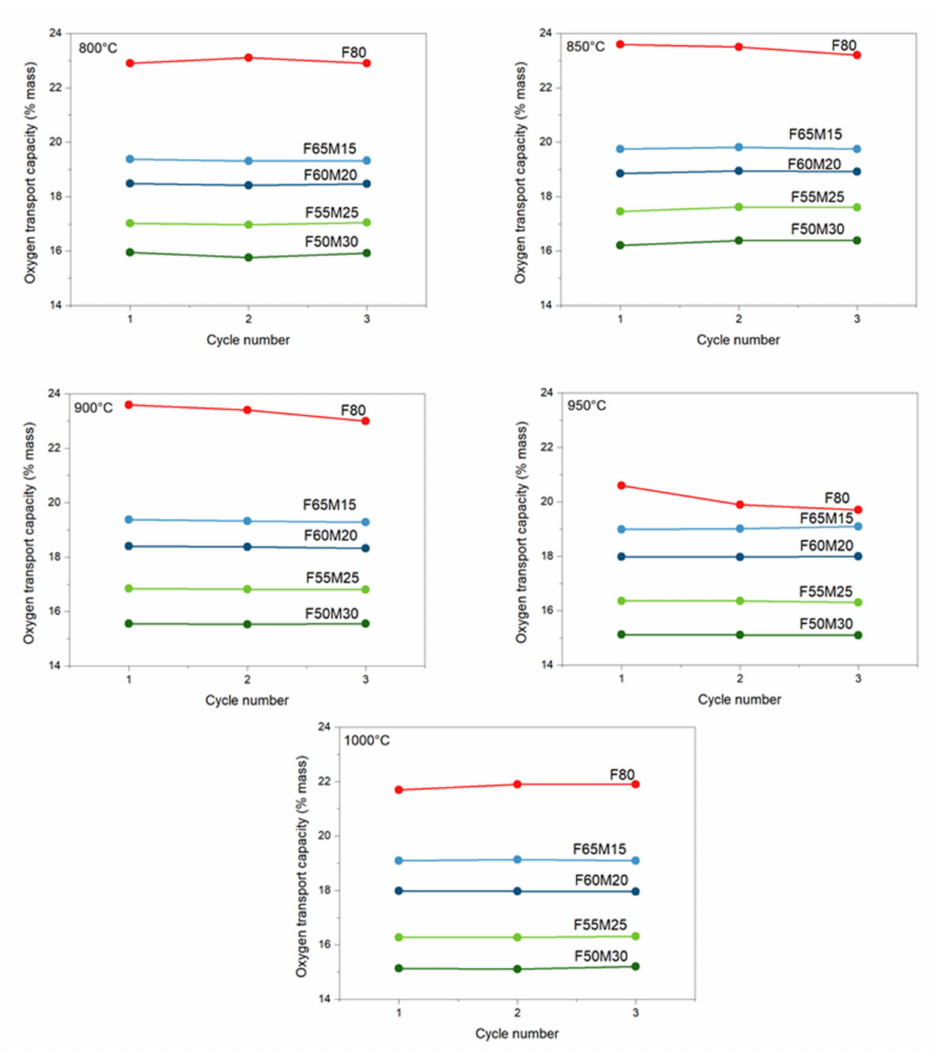
Figure 4. Stability of measured oxygen capacity for OCs at different